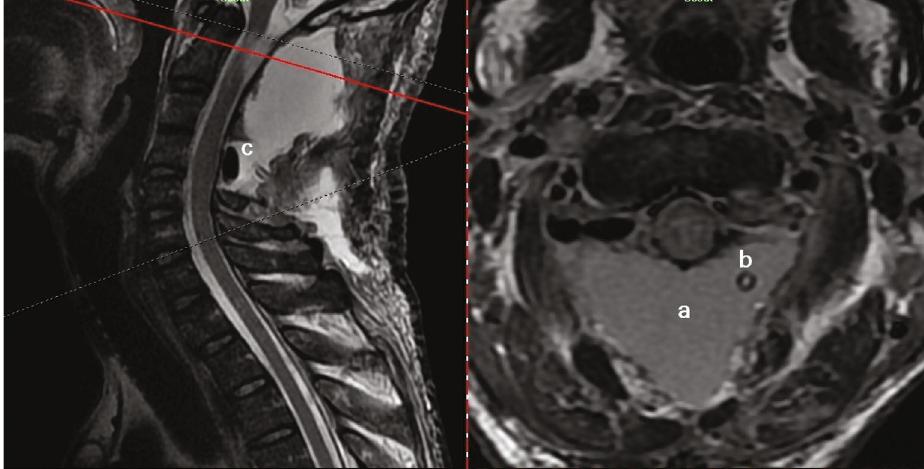
Figure 6: Sagittal-axial cross-view of postoperative T2WI of C1-C2 level showing dorsal CSF collection (a), hemovaccum tube (b), Gelfoam covering dura (c), and no remnant of bilateral C1-C2